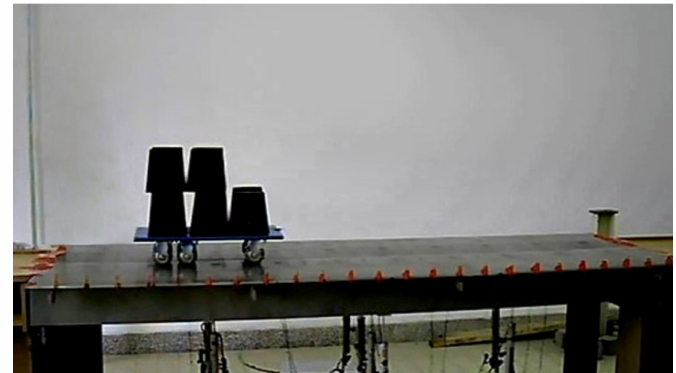
Figure 2. Photograph of the whole experimental system.